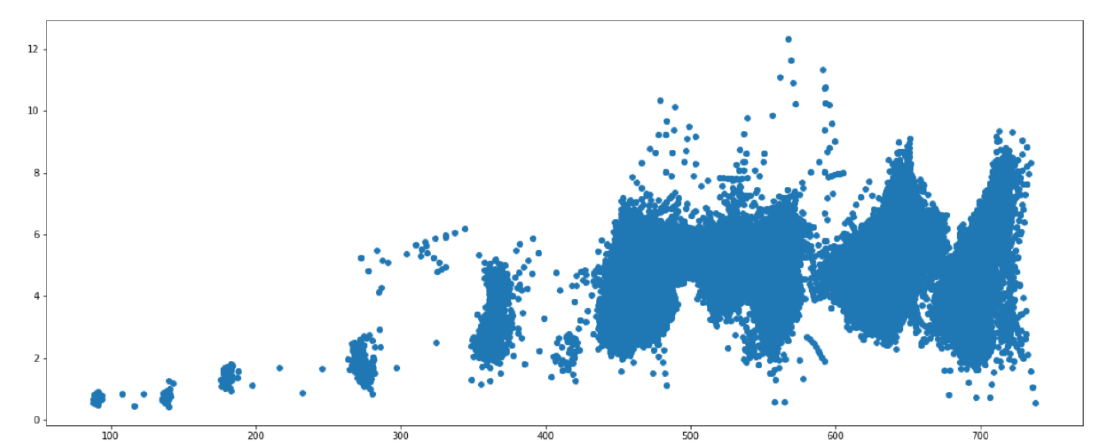
Figure 4. Scatter diagram of the condenser flow trend and COP. Energies 2020 , 13 , x FOR PEER REVIEW